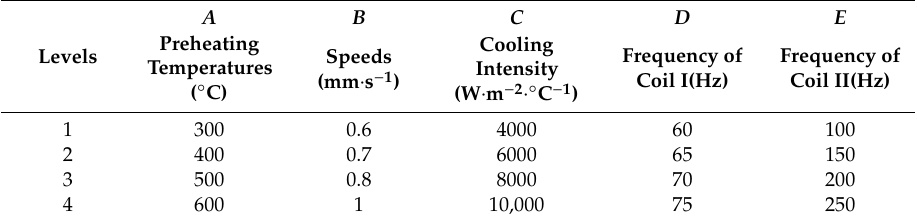
Table 2. Factors and levels of orthogonal experiment